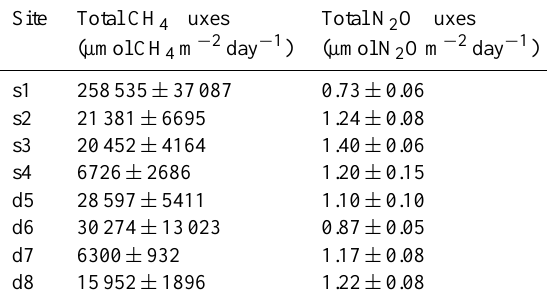
Table 2. Total water–air methane and nitrous oxide fluxes at sam- pling sites s1–s4 and d5–d8 of the spatial emission study. Rates are averaged over three surface floating chamber deployments. Sam- pling sites are numbered from shallowest to deepest site. Fluxes are given as an average ± SE, n =